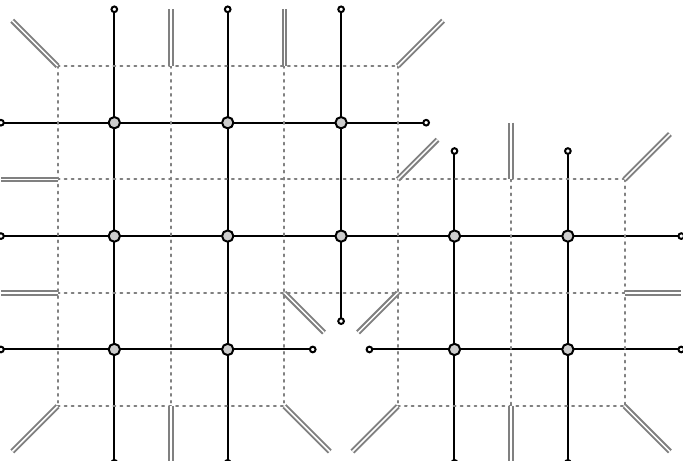
Figure 2 . A generic (cid:12)shnet graph with regular boundary. It is drawn by solid lines. It depends on a number of variables x (cid:22) which are coordinates of external legs. Each solid line of the (cid:12)shnet graph i represents the scalar propagator x (cid:0) 2 . Integrations are over positions of vertices (denoted by blobs). ij The dual graph is drawn by dotted lines. The dual graph lives in the momentum representation with integrations over loop momenta. Its external momentum variables are de(cid:12)ned as p (cid:22)